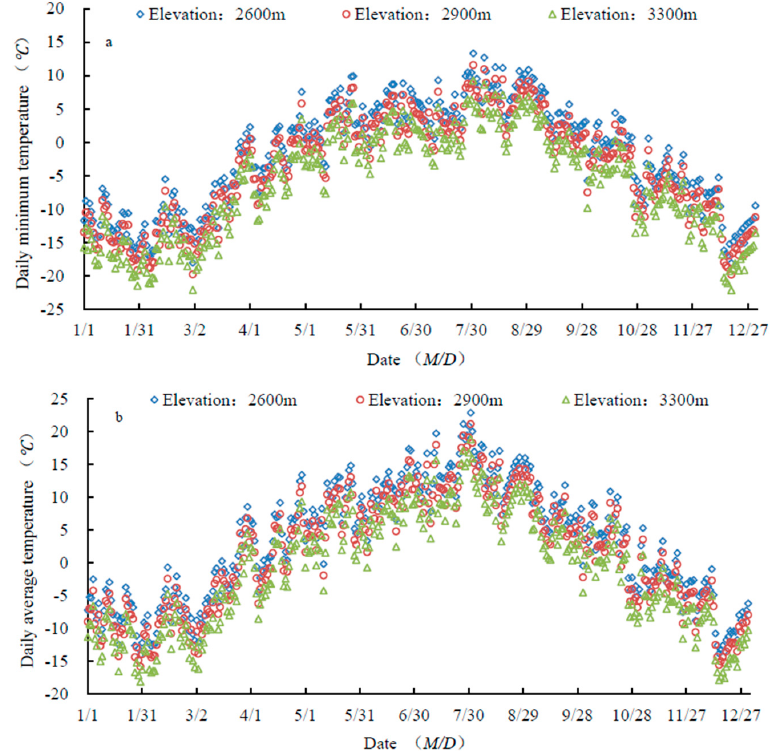
Figure 3. Variability in daily minimum temperature ( a ) and daily average temperature ( b ).